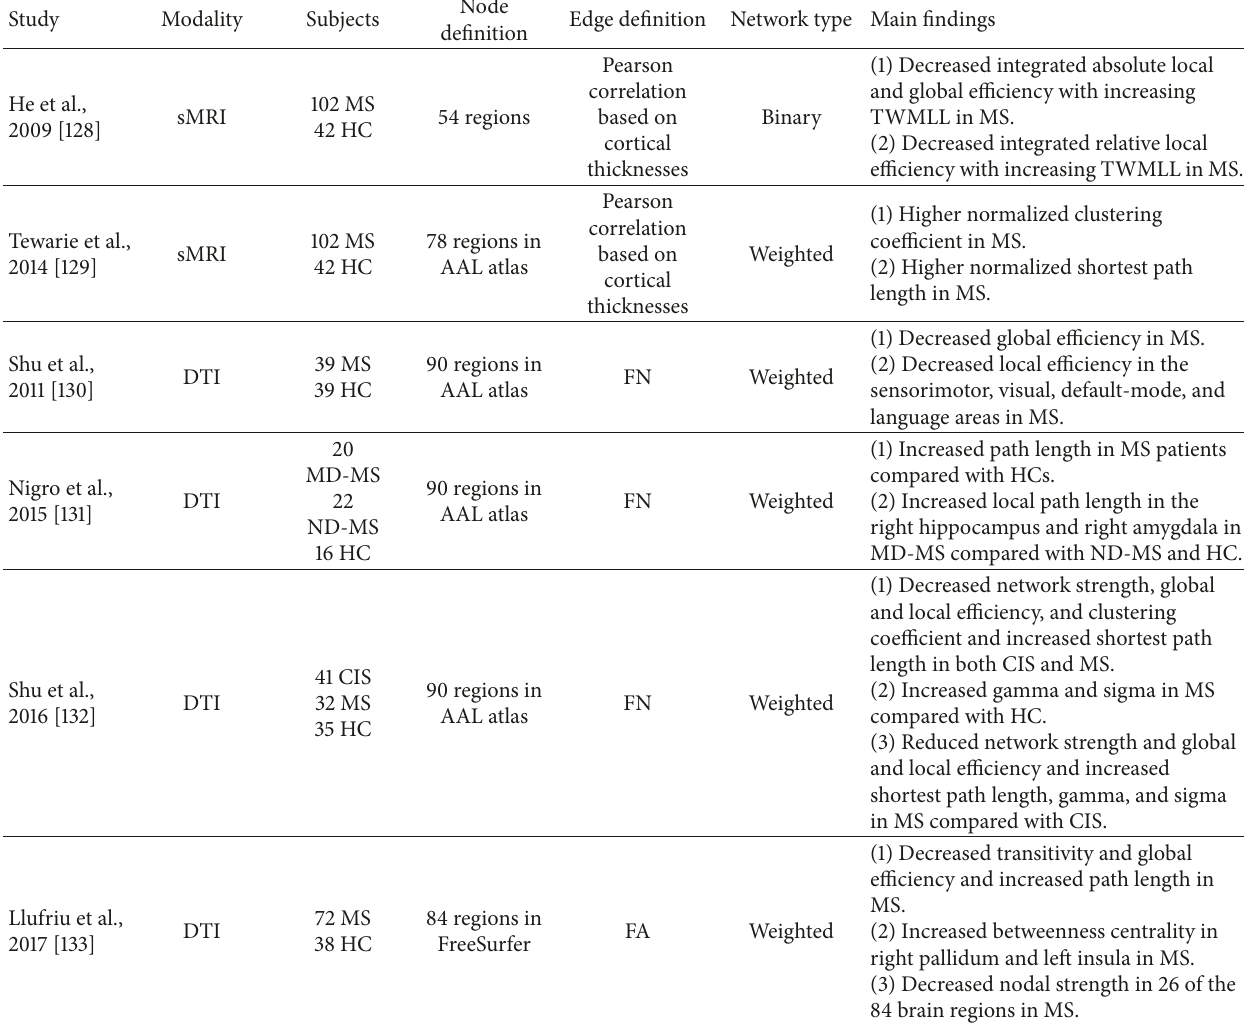
Table 8: Overview of structural brain network studies in